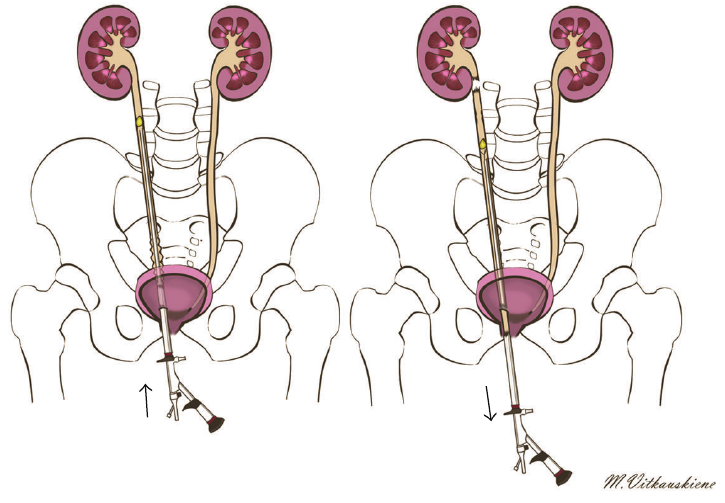
Figure 1: Scheme of complete ureter avulsion.